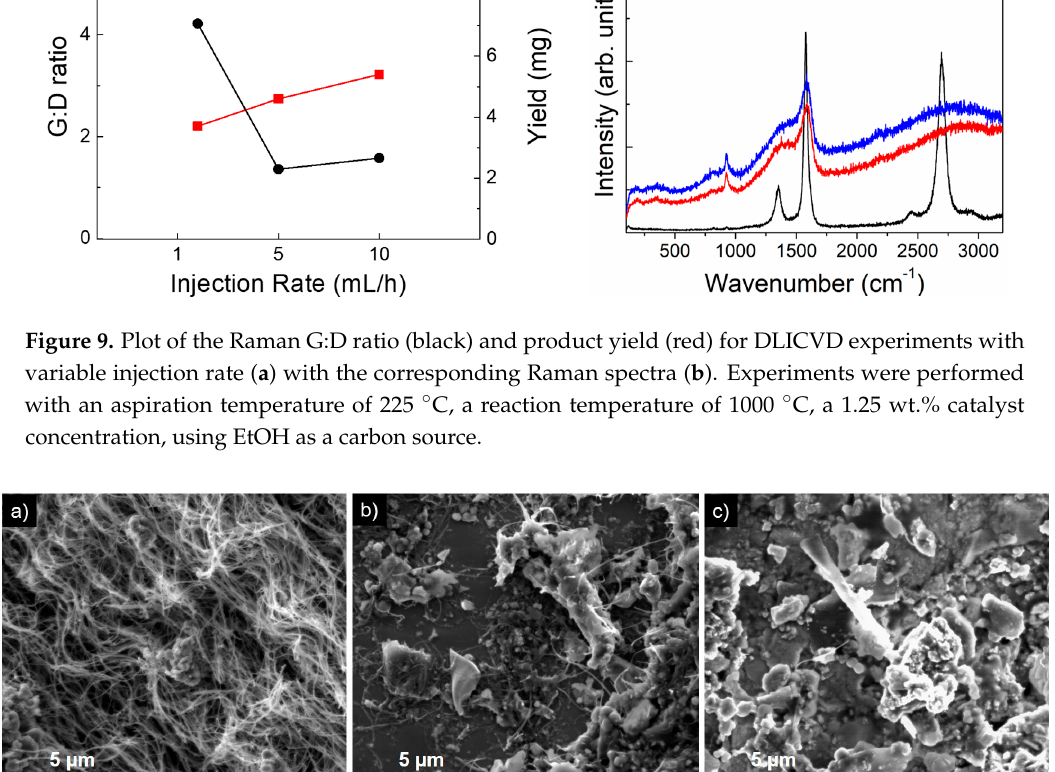
Figure 11. Plot of the Raman G:D ratio (black) and product yield (red) for DLICVD experiments with variable catalyst concentration (wt.%). Experiments were performed with an aspiration temperature of 225 °C, a reaction temperature of 800 °C, an injection rate of 1 mL/h, and EtOH as the carbon source. 3.7. Variation in Carbon Source. The choice of carbon source, hydrocarbons, or increasingly more common alcohols, can influence the nature of the CNT quality and product yield due to their varying decomposition products that determine CNT quality, morphology, and growth rate [48]. Furthermore, the choice of carbon source also impacts the relative C:H and the C:catalyst ratios that also influence CNT